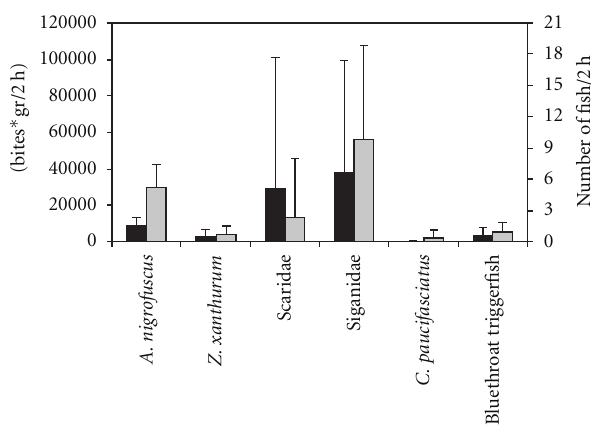
Figure 6: Night grazing observations during August 2008. Diadema setosum grazed for 66.3% of the total period of grazing, while Echinometra mathaei grazed for 33.6% of the total